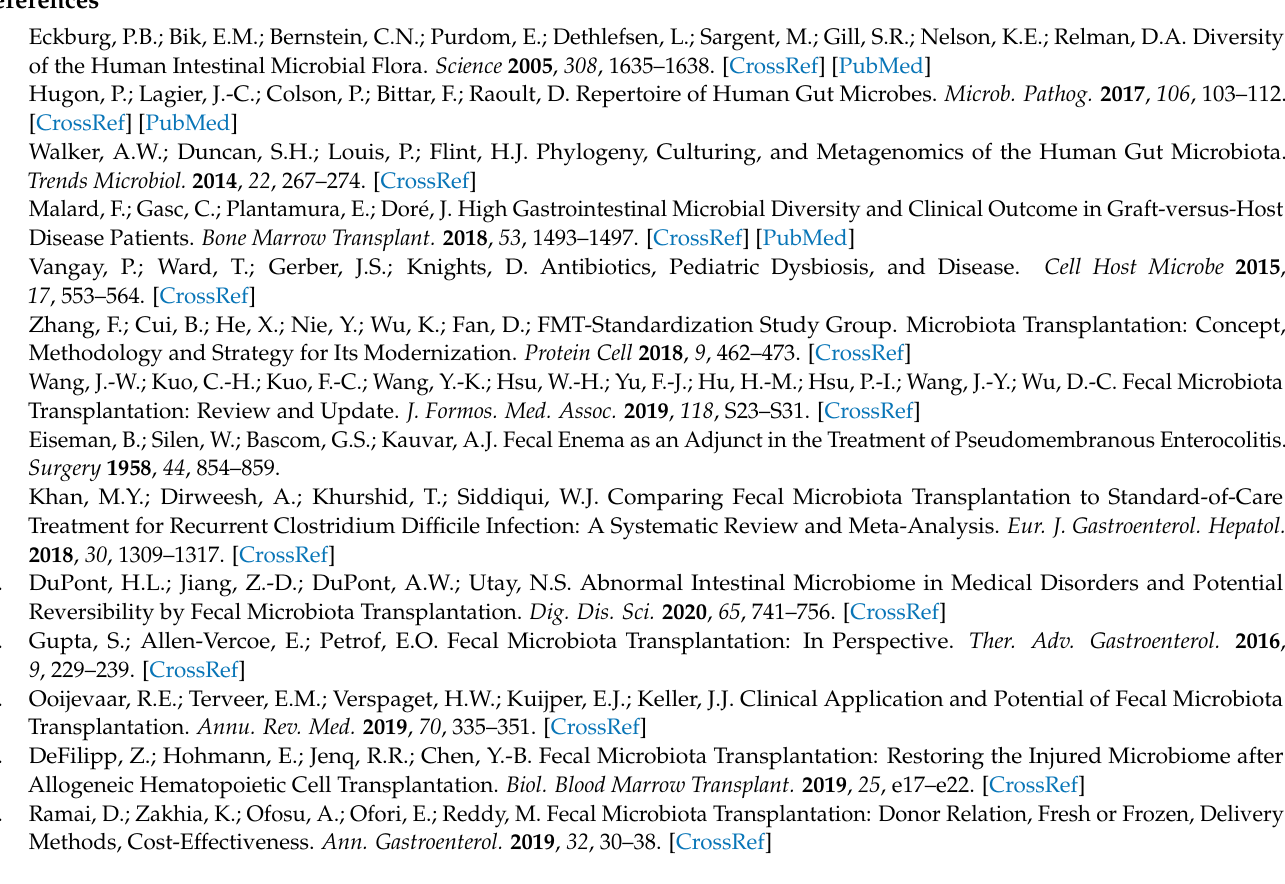
Figure S2: Effect of FMT treatment on Shannon index at OTU level, Table S1: Effect of FMT treatment on the duration of dysbiosis state (number of dysbiotic days) in the ARCOL